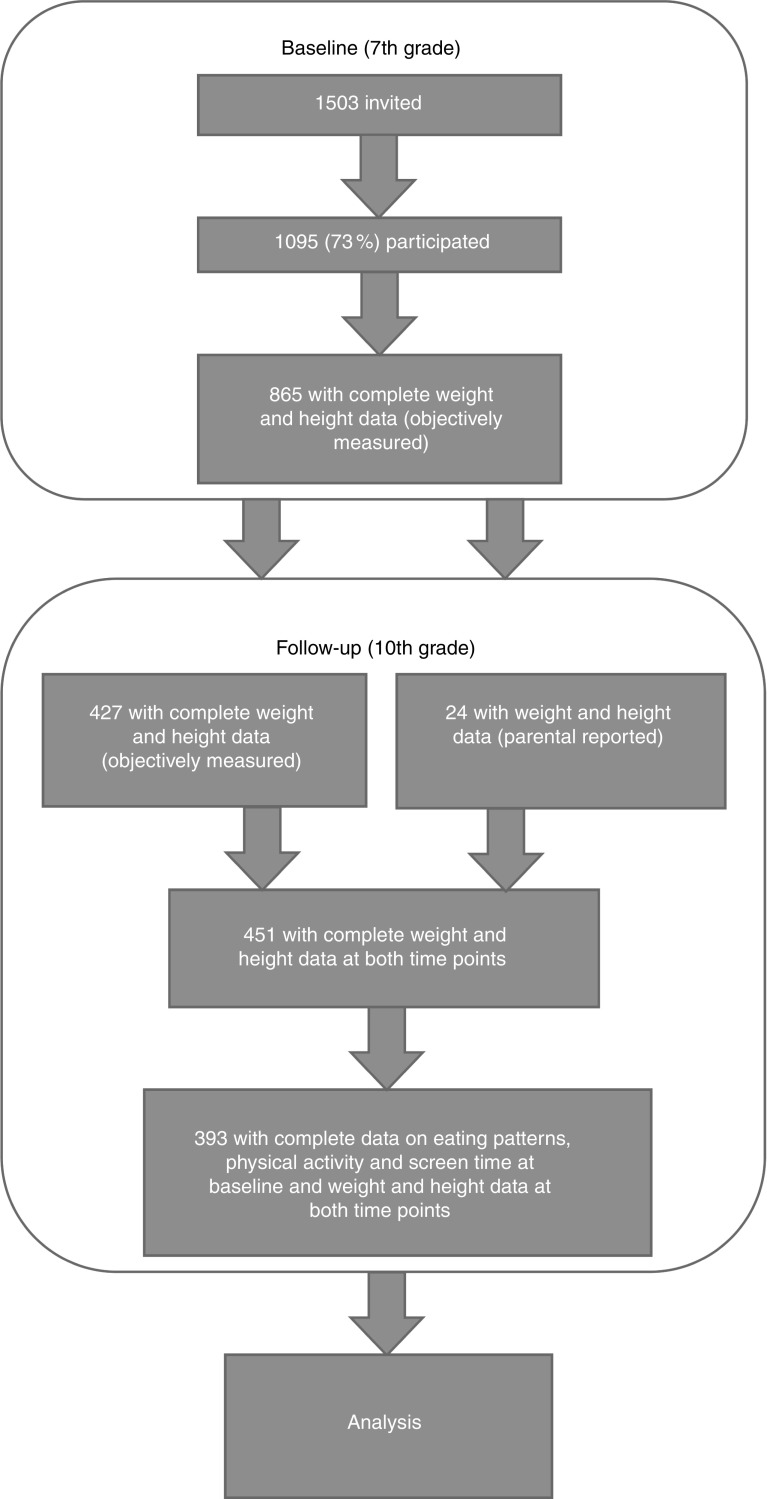
Overview of participants at baseline (in 7th grade, ages 12–13 years) and follow-up (in 10th grade, ages 15–16 years)